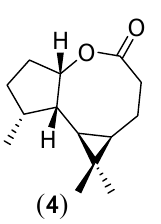
Figure 4: New sesquiterpene lactone